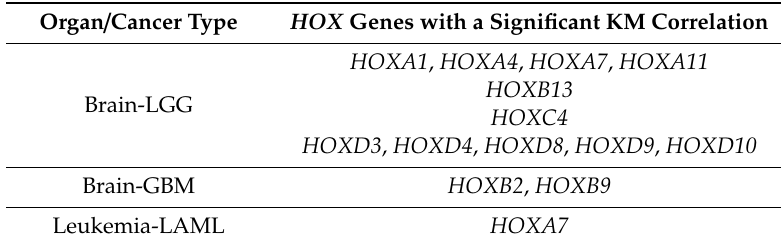
Table 3. HOX genes with statistically significant KM curve 1